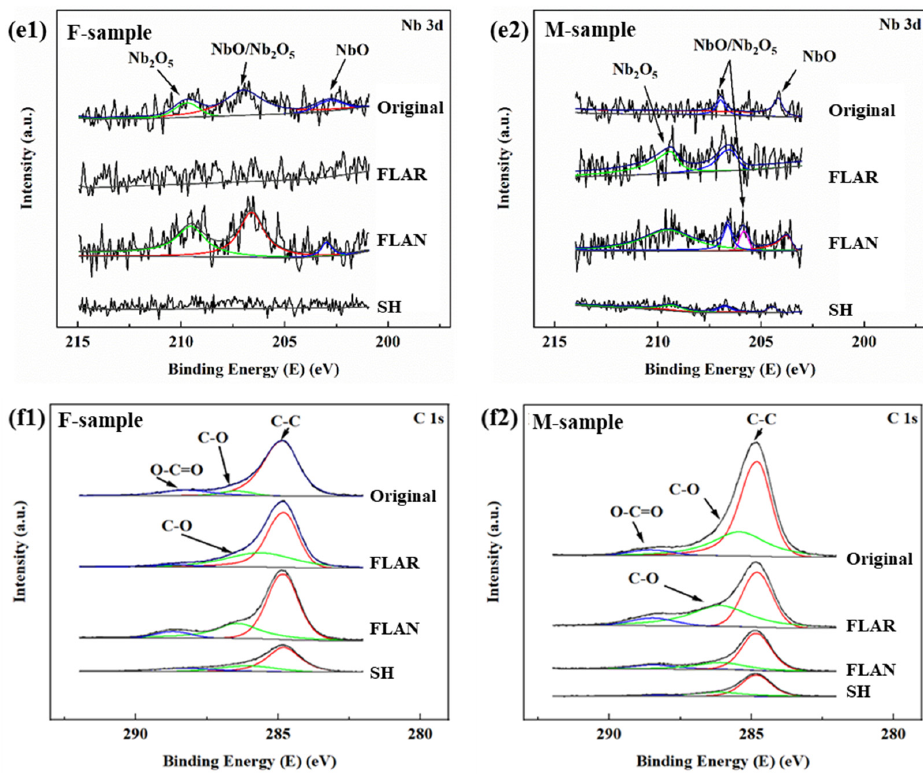
Figure 8. High-resolution XPS spectra of ( a ) Fe 2p, ( b ) Cr 2p, ( c ) Ni 2p, ( d ) Cu 2p, ( e ) Nb 3d, and ( f ) C 1s for SLM-ed samples after being immersed in 0.5 mol/L NaCl solution for 72 h.